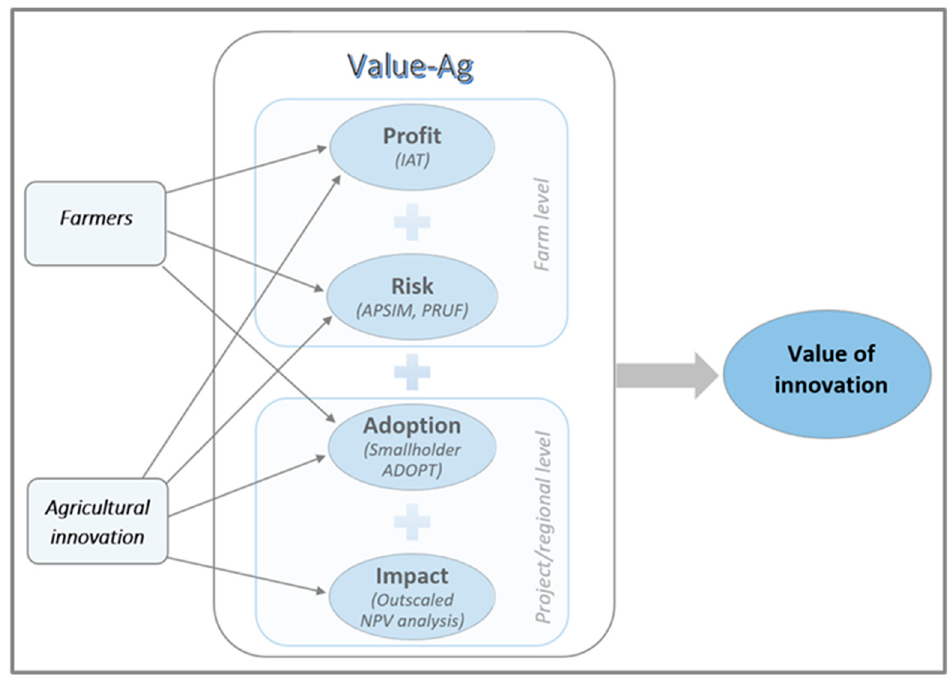
Figure 2. The Value-Ag framework combines whole-farm profit and risk at the farm level with broader adoption and short-cycle impact of an agricultural innovation to estimate its likely value.